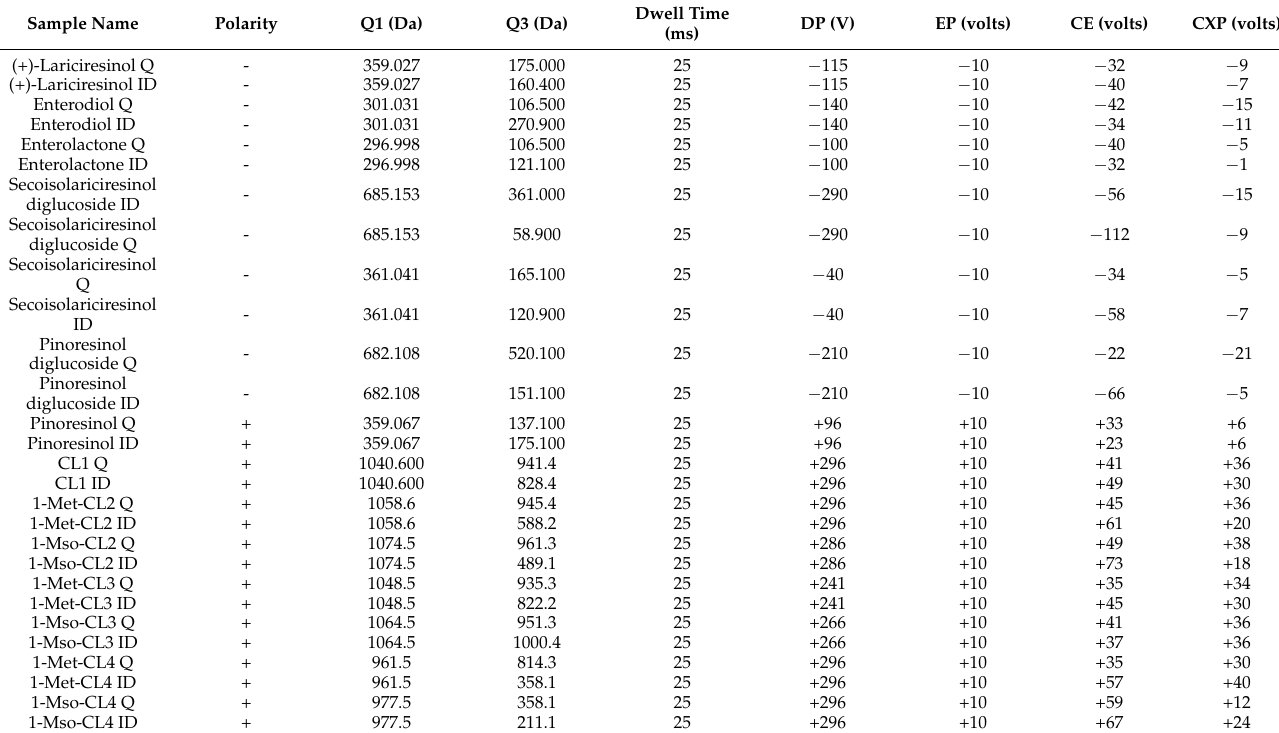
Table 3. Mass spectrometric settings for the MRM transitions of lignans and cyclolinopeptides. Q stands for quantifier and ID stands for identifier. A terminology showing the structural relations of the cyclolinopeptides was used: CL1 → CLA, 1-Met-CL2 → CLB, 1-Mso-CL2 → CLC, 1-Met-CL3